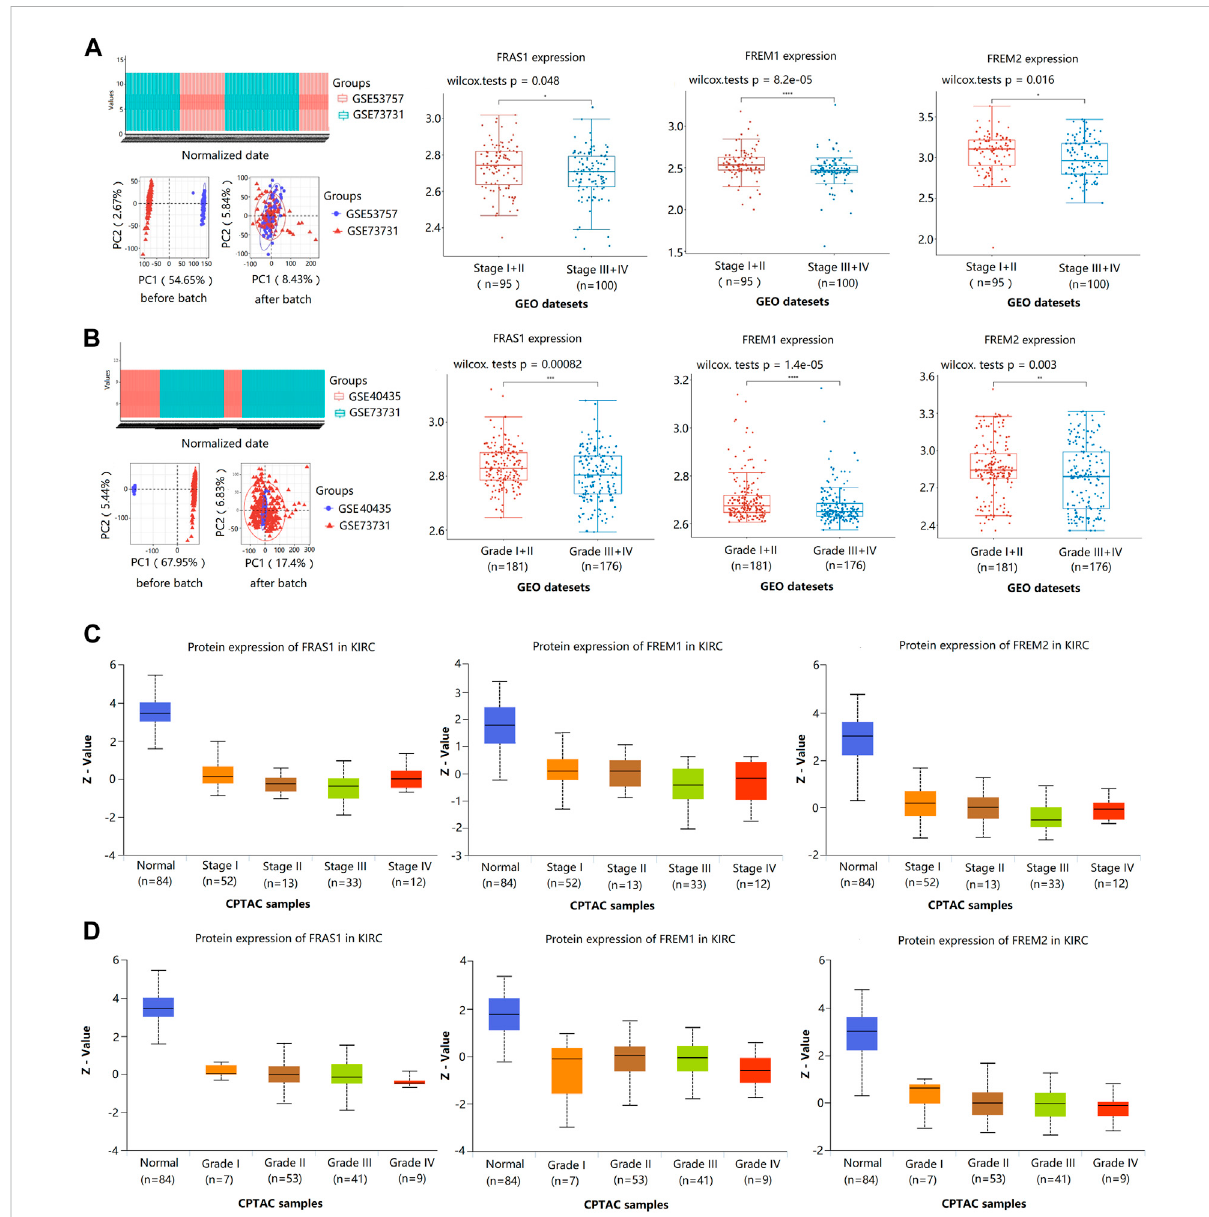
FIGURE 5 Correlation ofFRAS1/FREM mRNA expression with clinicalphenotypes inKIRC withdatesets fromGEO and CPTAC datebase. (A) Correlation of FRAS1/FREM mRNA expression with pathological stage in KIRC with datesets from GEO datebase (GSE53757 and GSE73731) (* p < 0.05, **** p < 0.0001). (B) Correlation of FRAS1/FREM expression with pathological grade in KIRC with datesets from GEO datebase (GSE40435 and GSE73731) (* p < 0.05, **** p < 0.0001). (C) Correlation of FRAS1/FREM protein expression with pathological stage in KIRC with datesets from CPTAC datebase. (D) Correlation of FRAS1/FREM protein expression with pathological grade in KIRC with datesets from CPTAC